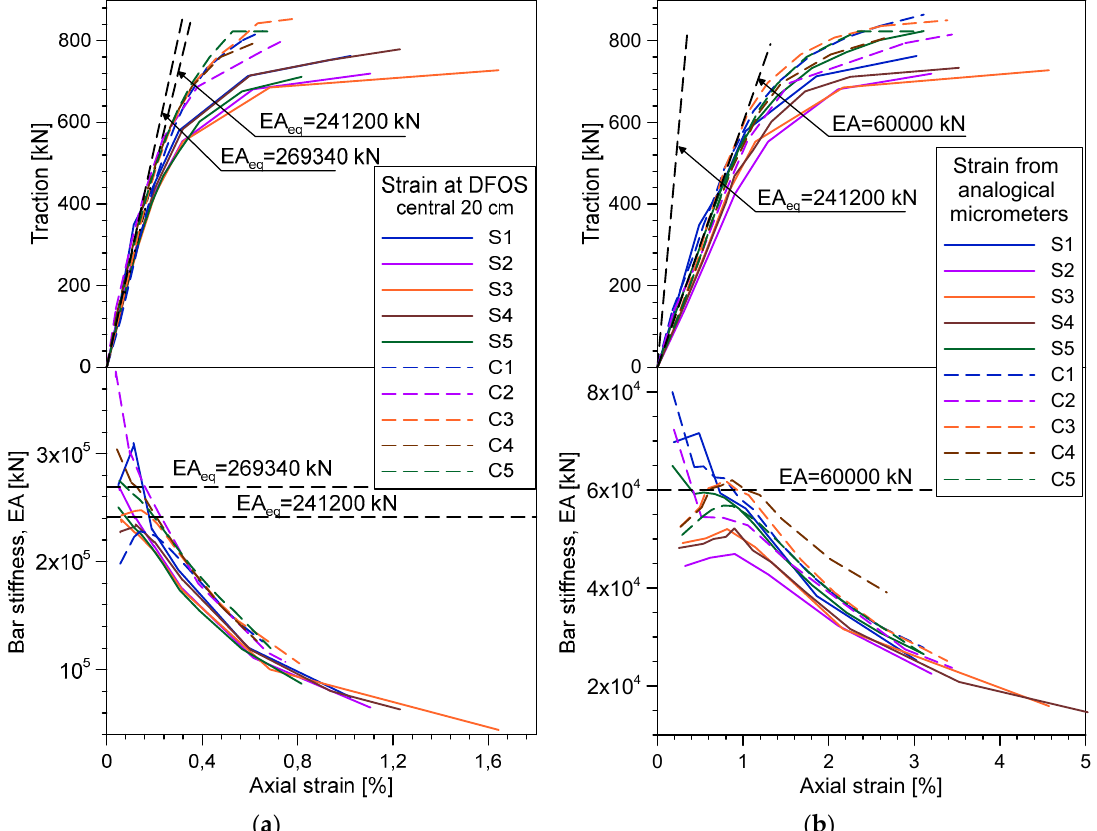
Figure 9. Comparison of traction and bar equivalent stiffness vs strain of simple and composite bars tested in the laboratory: ( a ) mean strain recorded by the DFOS in the central 20 cm; ( b ) mean strain recorded by external analogical micrometers.